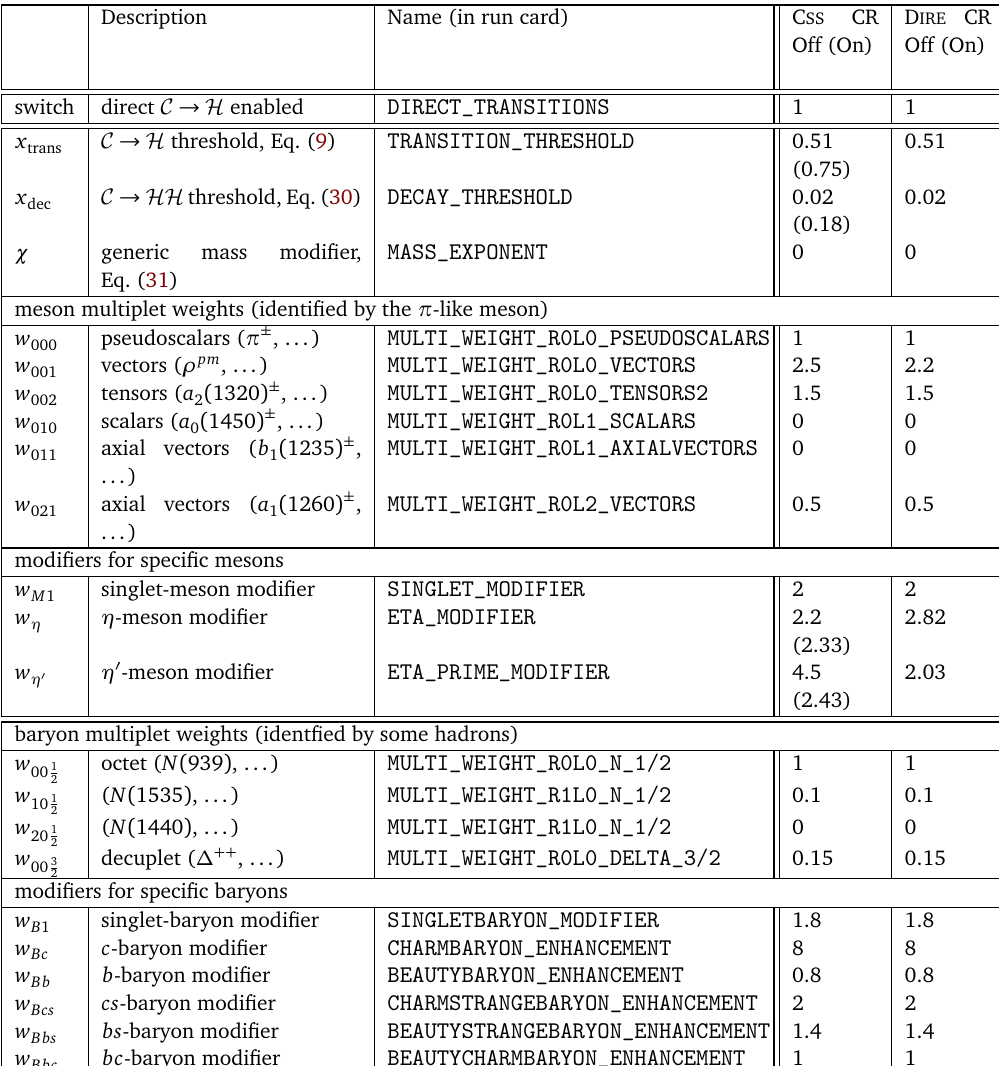
Table 5: Tuned parameters used in the selection of the specific channel in + H + γ decays, cf. Eq. (31), including multiplet weights, C → H and C → H 1 2 1 and modifiers for individual hadrons or classes of hadrons.